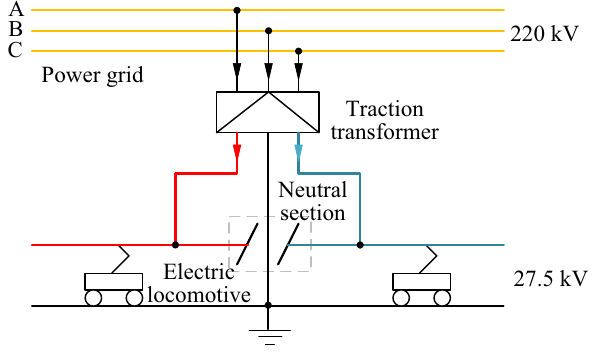
Fig. 1 Structure of standard ERS